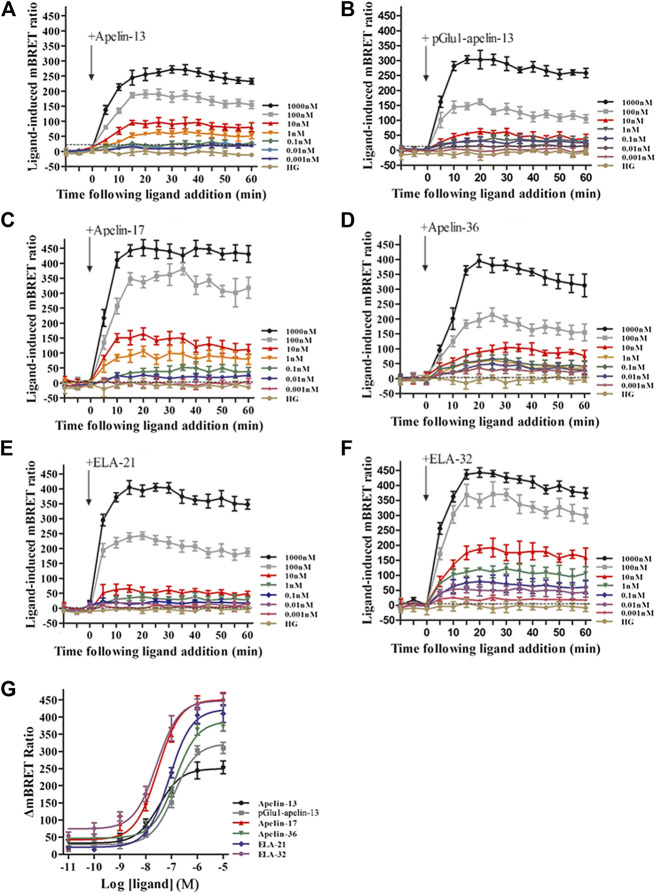
The time-response curve (A–F) and dose-response curve (G) of interactions between APJ and β-arrestin1 induced by the six agonists in different concentrations, obtained from real-time dynamic BRET determination. p < 0.05 was considered as statistically significant. Control group (HG, Cells were stimulated with high glucose). In HEK293 cells expressing APJ and β-arrestin 1, the dose-response curves of the six peptides at 20 min were observed. The data represent means ± SEM of four independent experiments. Statistical analysis (Supplementary Table S5).